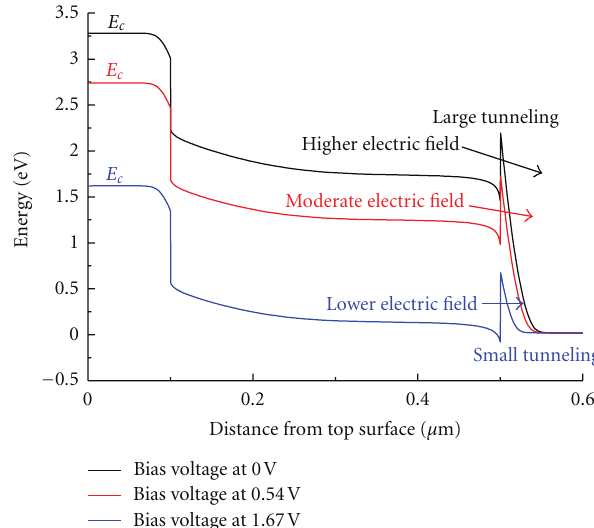
Figure 5: The conduction band energy diagram of In 0 . 3 Ga 0 . 7 N pin solar cells at the voltage bias of 0, 0.54 and 1.67 V.